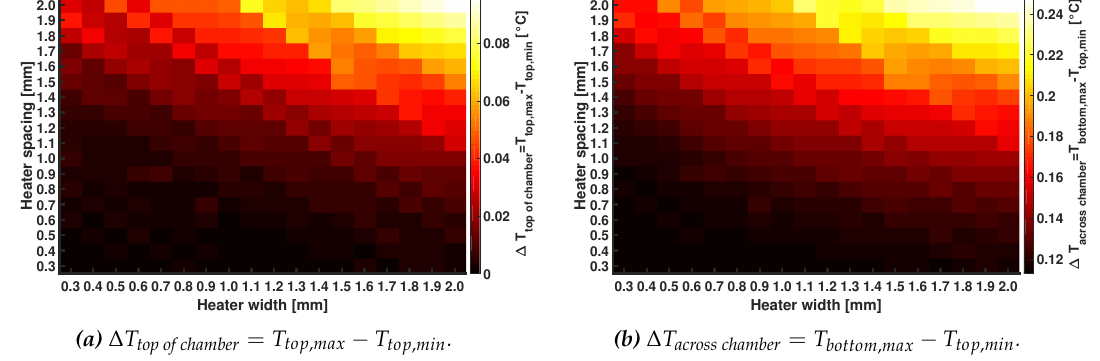
(a) ∆ T top of chamber = T top , max − T top , min . (b) ∆ T across chamber = T bottom , max − T top , min .